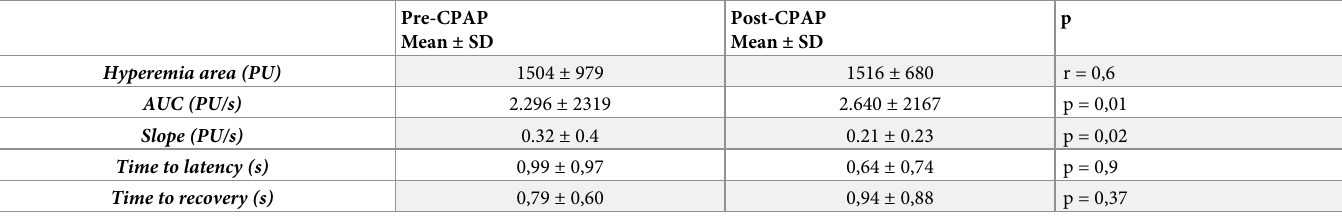
Table 2. Endothelial function improves after 3 months of CPAP treatment.